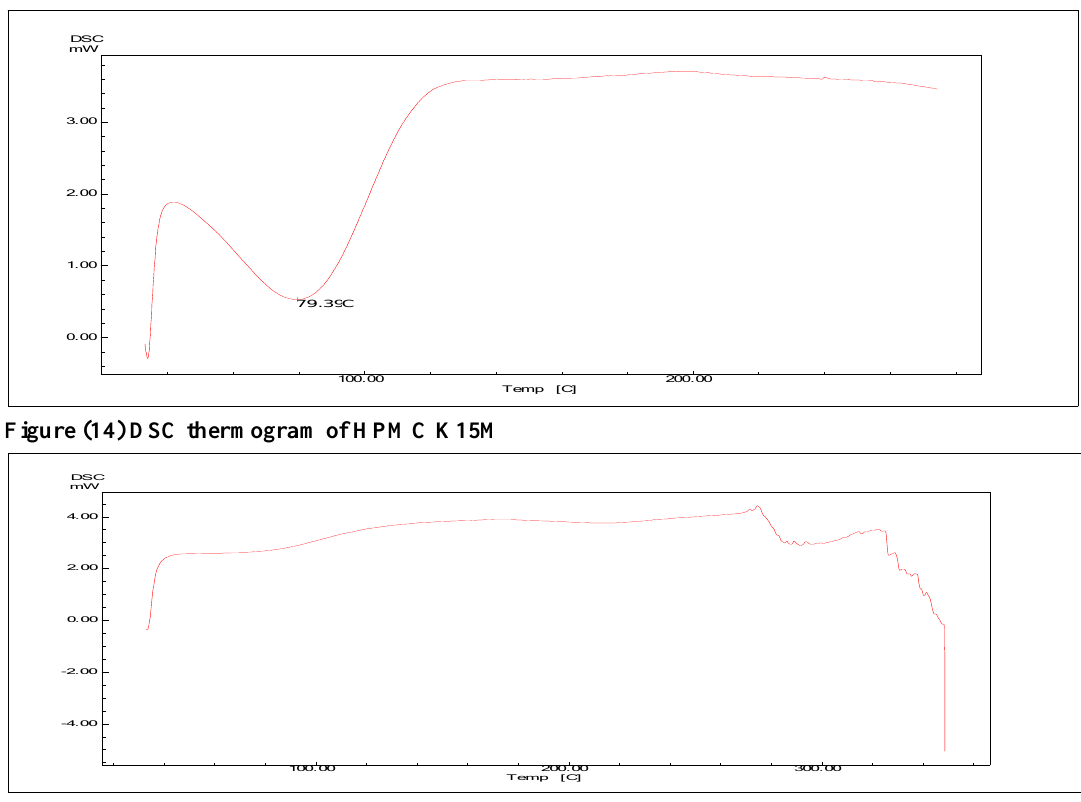
Figure (15) DSC thermogram of selected rebamipide ocular insert